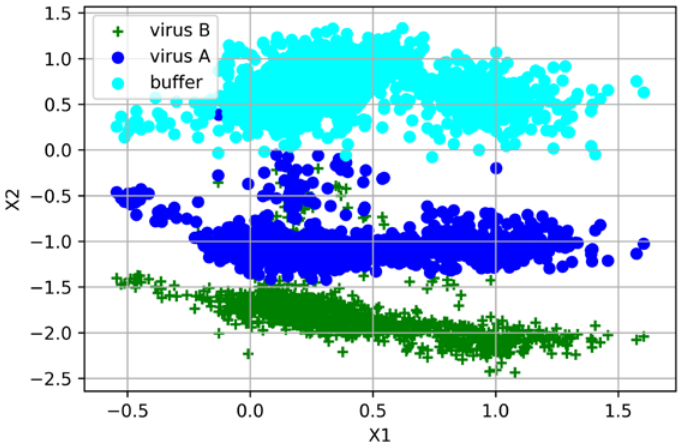
Figure 8. Visual representation of the spectra classification by support vector machine showing the projection of the samples onto support vectors X1 and X2: light blue—the pure STE buffer medium; dark blue—the influenza A virus in the STE buffer medium; green—the influenza B virus in the STE buffer medium.